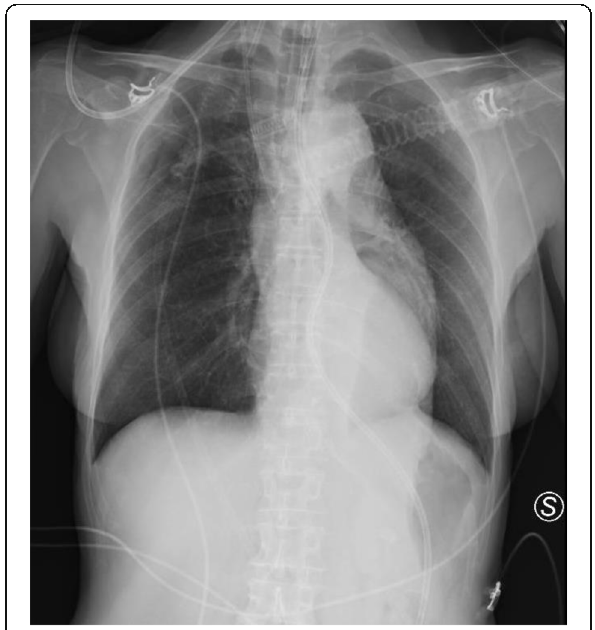
Fig. 1 (abstract A198). Anteroposterior chest radiograph taken after CVC placement shows partial lung atelectasis around the hilum of the left